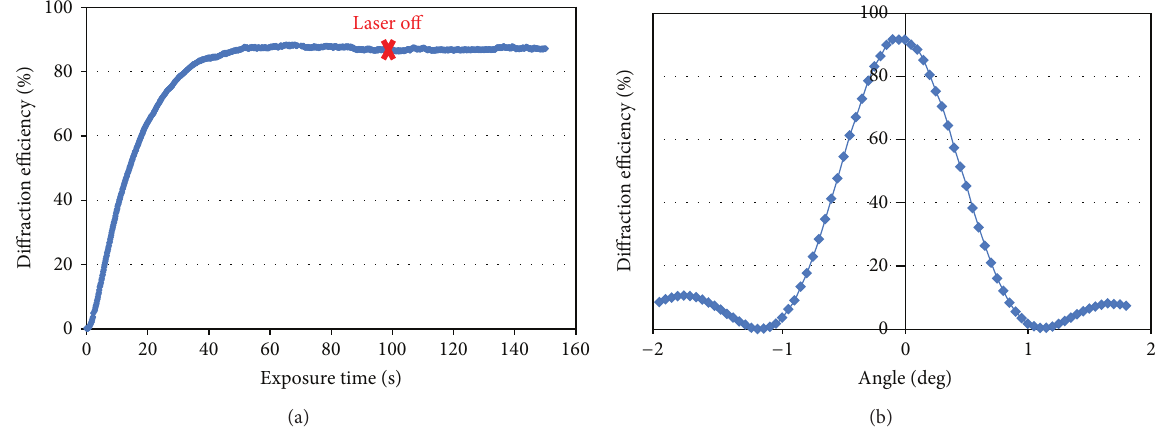
Figure 5: (a) Real-time diffraction efficiency growth curve for a 60 ± 10 𝜇 m DA photopolymer layer exposed to a total recording intensity of 2mW/cm 2 . (b) Diffraction efficiency versus incident angle of probe beam.